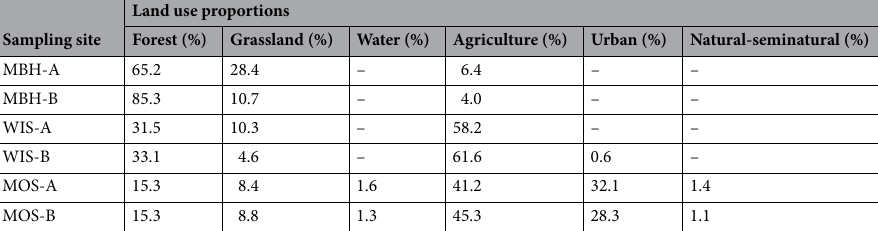
Table 5. Land use classes and proportions in % in catchment parts upstream of respective sampling sites upstream (A) and further downstream (B) of the streams Mähringsbach (MBH), Wiesent (WIS) and Moosach